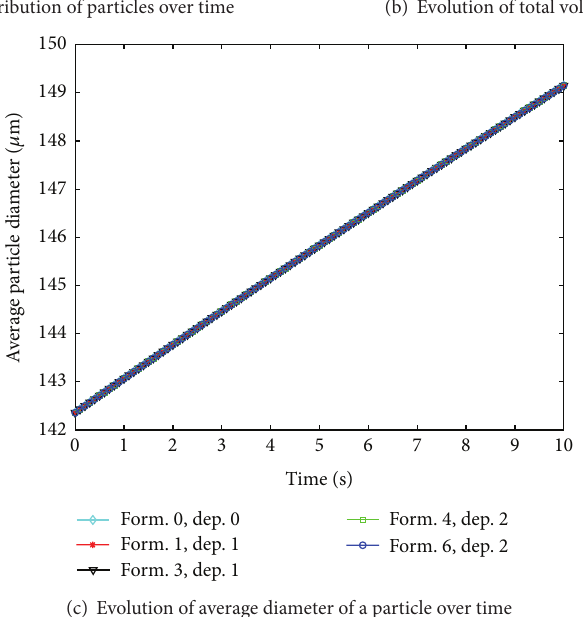
Figure 3: Comparison of temporal evolution of granule physical properties simulated for different worker pool classes, grid size = 36. granule physical properties, Figures 3(a)–3(c), were exam- ined to ensure validity and numerical precision of the